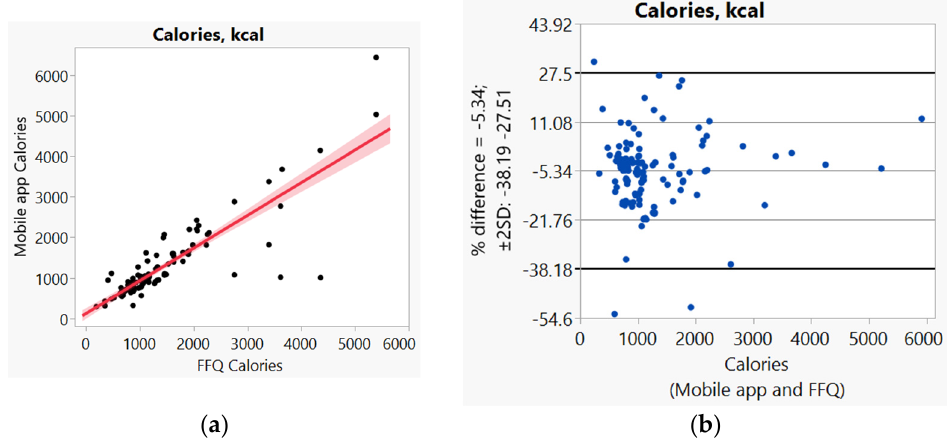
Table 1. Agreement and bias for the mobile application against Food Frequency Questionnaire ( N = 135).